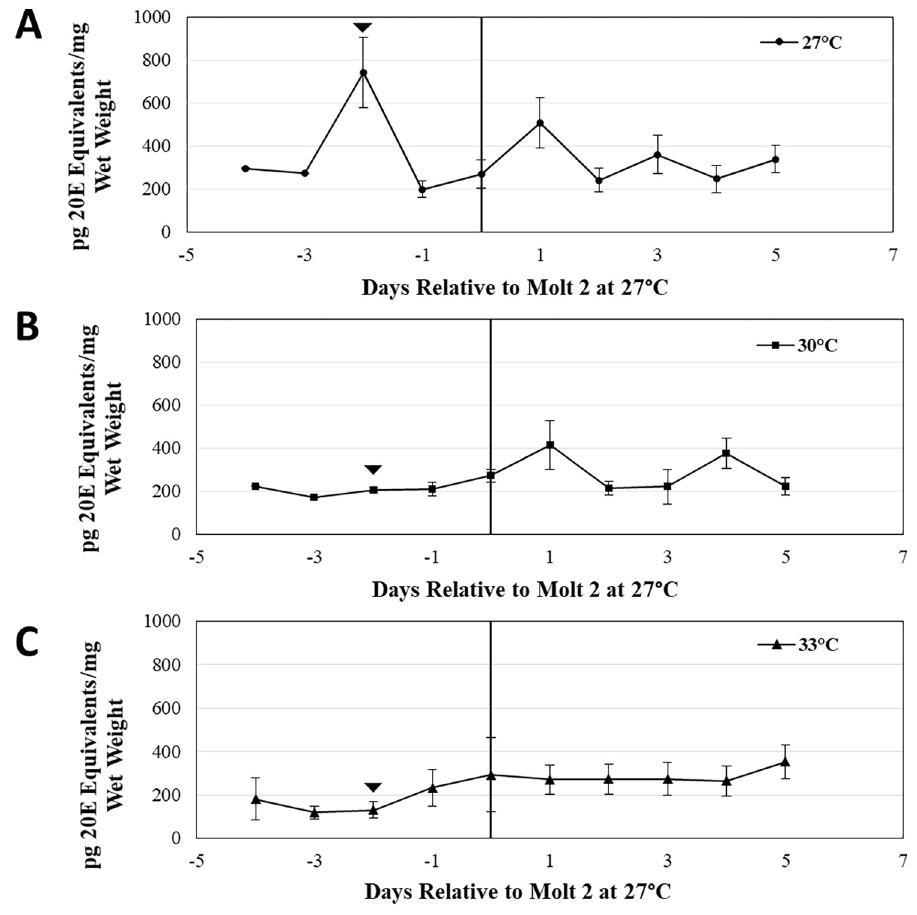
Fig 2. Developmental ecdysteroid profiles at different temperatures. (A-C) Average daily ecdysteroid titers from spiderlings reared at 27˚C (A), 30˚C (B), and 33˚C (C). Only families that had spiderlings reared at both temperatures were used for analysis. Spiderling ages are relative to the timing of the second molt for each family, at 27˚C. Error bars represent standard error.